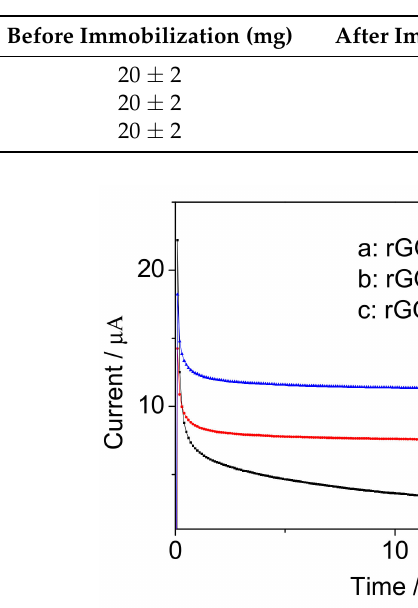
Figure 9. The chronoamperometry signals measured for 50 mg/L BOD using the prepared microbial biofilms of rGO- B (a), rGO-Py- B (b) and rGO-PPy- B (c),